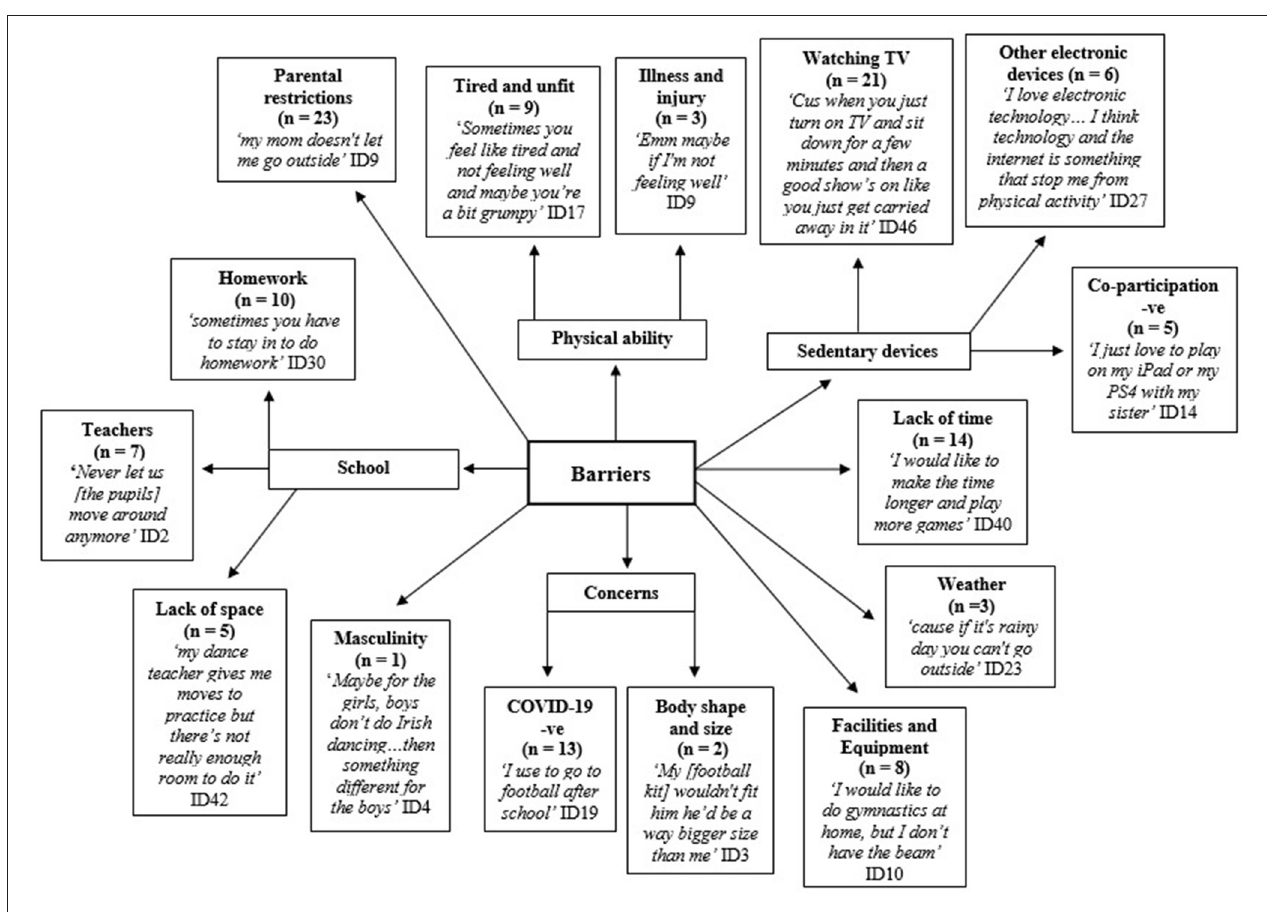
FIGURE 5 | Barriers to children’s physical activity -ve = negative.